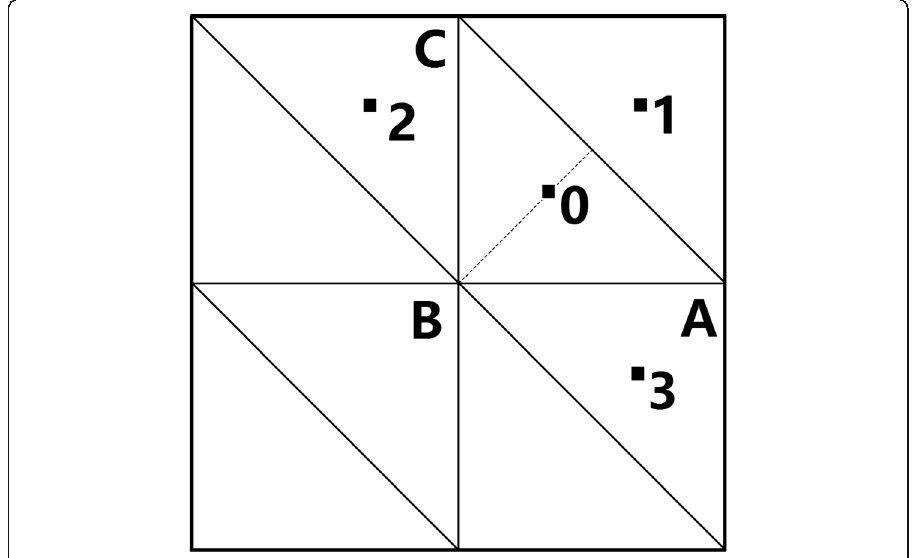
Fig. 5 Regular triangular grid stencils ( AR = 1; reg.